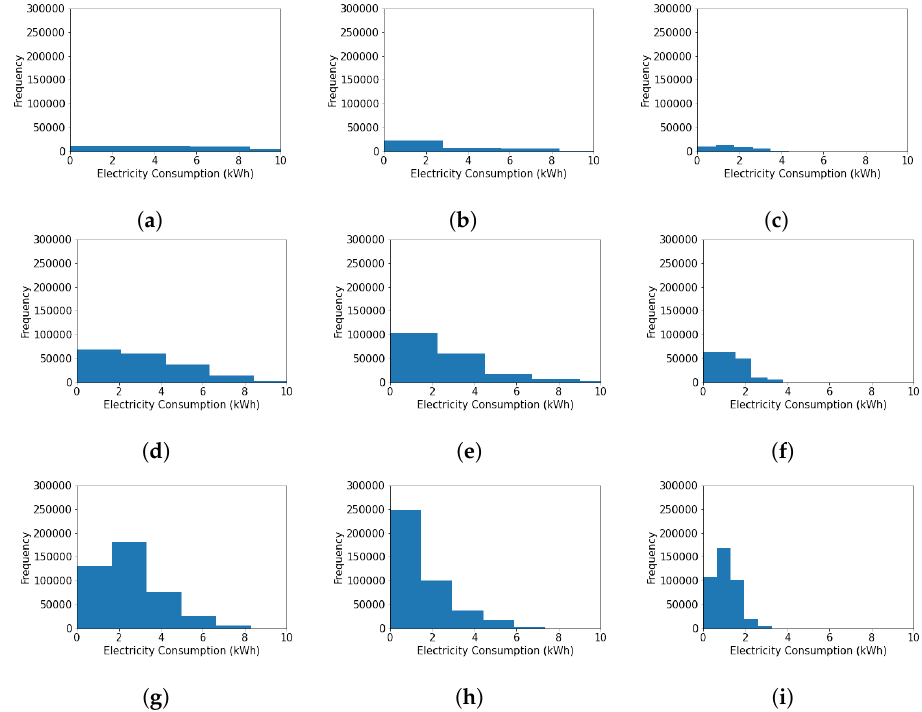
Figure 5. Distribution of the cumulative energy consumption (kWh) for each experiment condi- tion: ( a ) 10 vehicles, 10 non-adherence; ( b ) 10 vehicles, 5 non-adherence; ( c ) 10 vehicles, 0 non- adherence; ( d ) 50 vehicles, 50 non-adherence; ( e ) 50 vehicles, 25 non-adherence; ( f ) 50 vehicles, 0 non- adherence; ( g ) 100 vehicles, 100 non-adherence; ( h ) 100 vehicles, 50 non-adherence; ( i ) 100 vehicles, 0